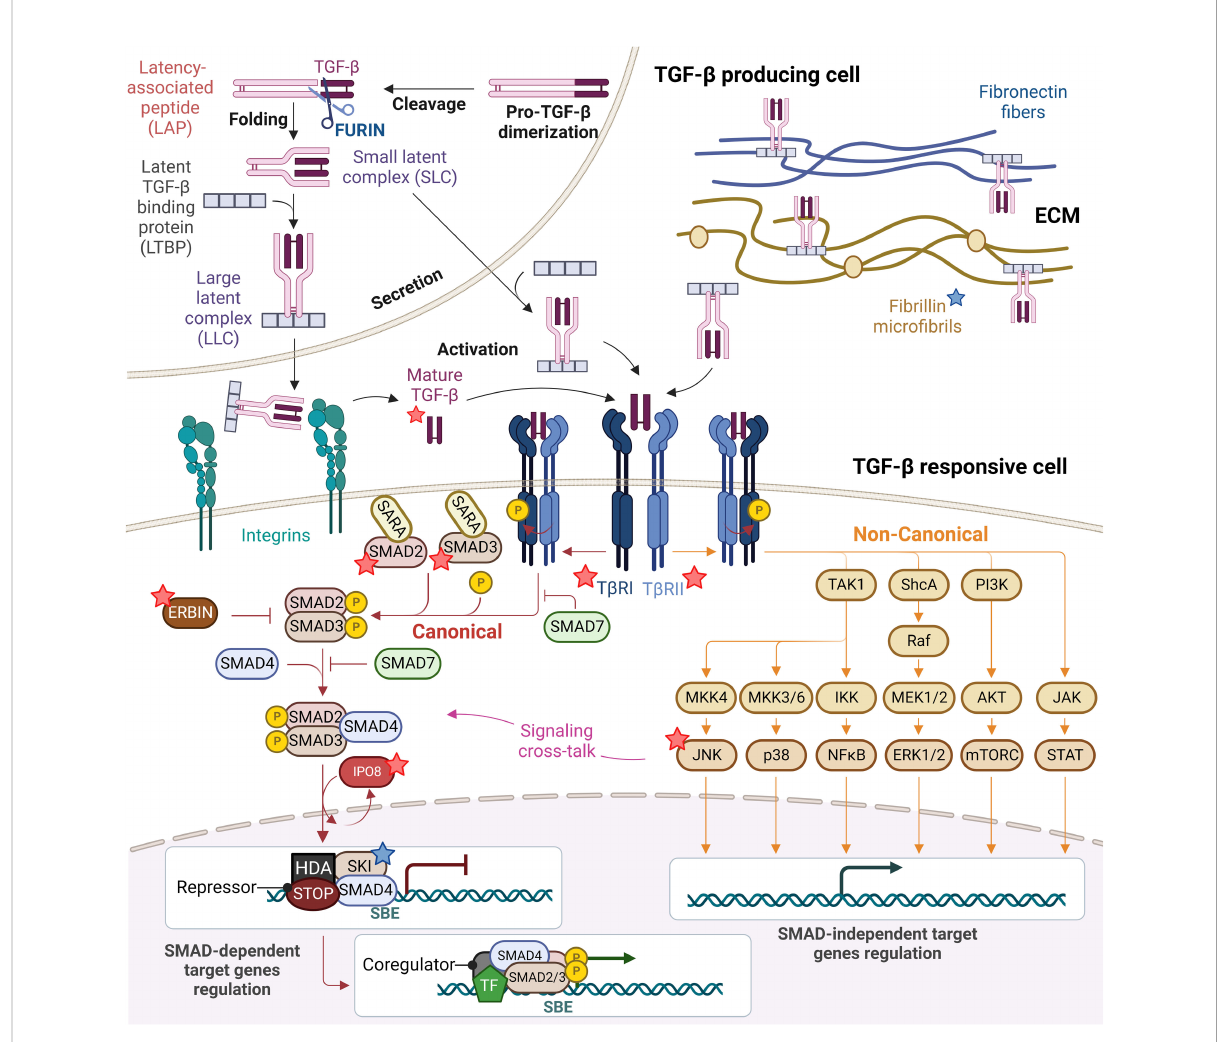
FIGURE 1 TGF- b signaling pathway: from TGF- b biogenesis to gene expression regulation. Mature TGF- b is secreted in form of small and large latent complexes (SLC and LLC) and associates with fi bronectin fi bers and fi brillin micro fi brils composing the extracellular matrix (ECM), as well as with plasma membrane-associated proteins (not shown). Upon interaction with extracellular proteases and integrins on the surface of TGF- b responsive cells, mature TGF- b is released. Active TGF- b binds to type II receptors (T b RII), which recruits and activates type I receptors (T b RI). Receptor-induced phosphorylation of SMAD2 and SMAD3 induces their dissociation from SARA and formation of SMAD2/3-SMAD4 complexes which in turn translocate to the nucleus in an IPO8-mediated manner to initiate signaling. In the absence of TGF- b , SKI is bound to DNA at Smad Binding Elements (SBEs) with SMAD4, recruiting others repressors and histone deacetylases (HDA) to inhibit the expression of TGF- b target genes. SMAD6/7 attenuate ligand-induced SMAD activation, preventing SMAD2/3 recruitment to T b RI and competing with SMAD4 for binding to SMAD2/3, while ERBIN competes with SARA for binding to SMAD2/3, segregating phosphorylated SMAD2/3 in the cytoplasm. The TGF- b T b RI/T b RII complex can also activate non-canonical non-SMAD signaling pathways, including the ERK MAP kinase and the p38 MAPK and JNK pathways, the PI3K-AKT-mTOR and the JAK-STAT signaling, which overall complement SMAD-dependent signaling and strongly complicate the output of a TGF- b trigger. Proteins found mutated in TGF- b signalopathies are indicated with a star, blue if patients do not present with immune dysregulation ( fi brillin and SKI), red if they present with immune dysregulation (TGF- b 1, TGF- b RI and TGF- b RII, SMAD2 and SMAD3, IPO8, ERBIN and